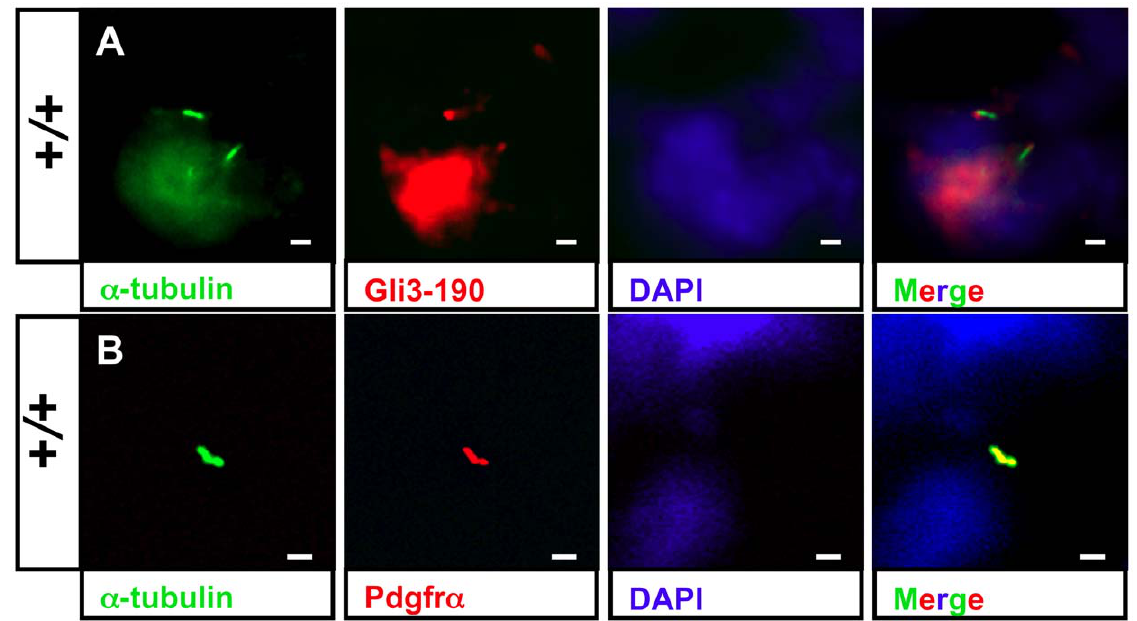
Figure 6. Shh and Pdgfr a signaling components localize at cardiac cilia. (A + B) Immunofluorescence on transverse heart sections at E11.5. Cilia are stained in green by acetylated a -tubulin and cell nuclei in blue by DAPI. Scale bars (in white) represent a length of 2 m m. (A) Ciliary Gli3-190 localisation (red staining) in wild-type ventricles demonstrates that Shh signaling is transduced by ventricular cilia. (B) Pdgfr a (red staining) is distributed along cardiac cilia in wild-type ventricles.